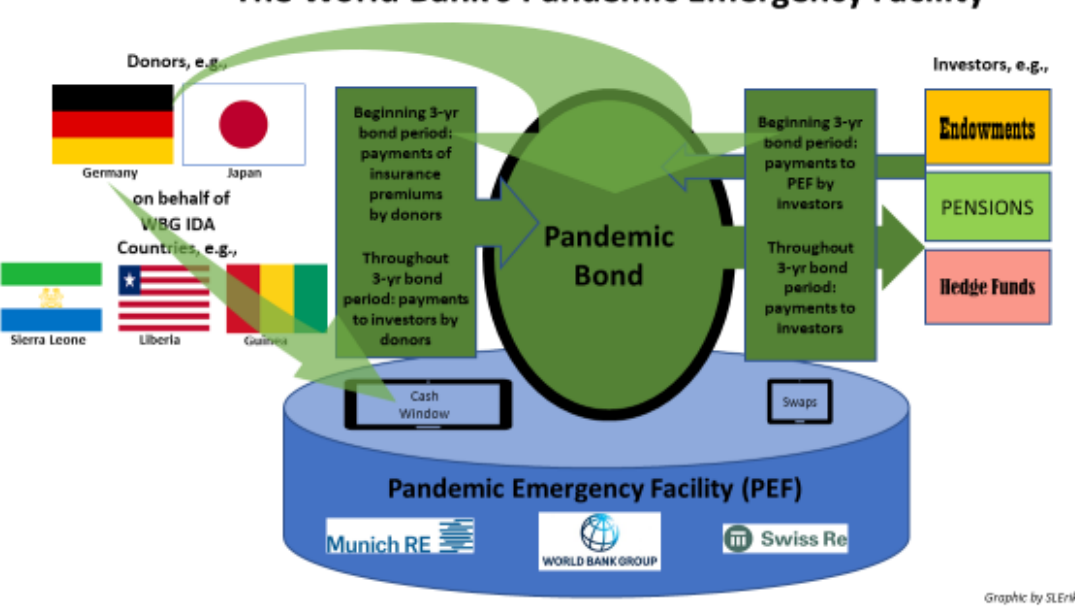
Figure 1. The pandemic bond as part of the World Bank’s financial device, the Pandemic Emergency Facility. Graphic copyrighted by